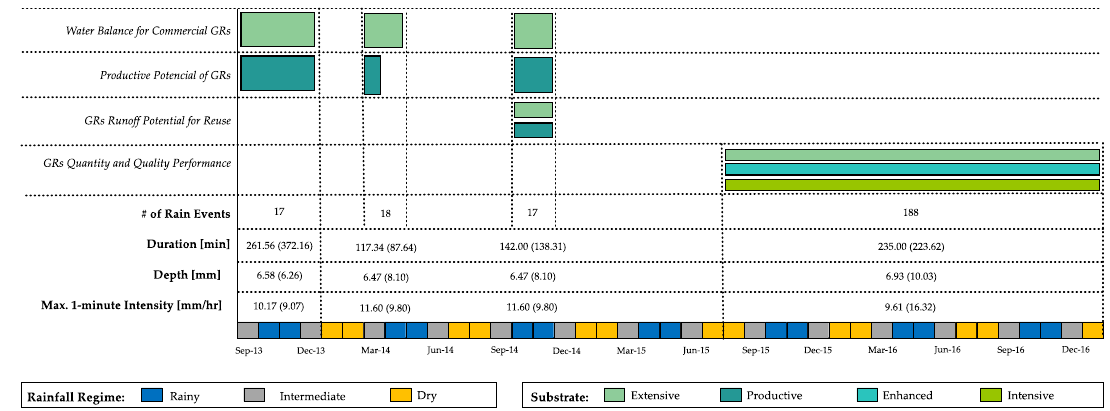
Figure 4. Rainfall events characteristics for the different monitoring periods.